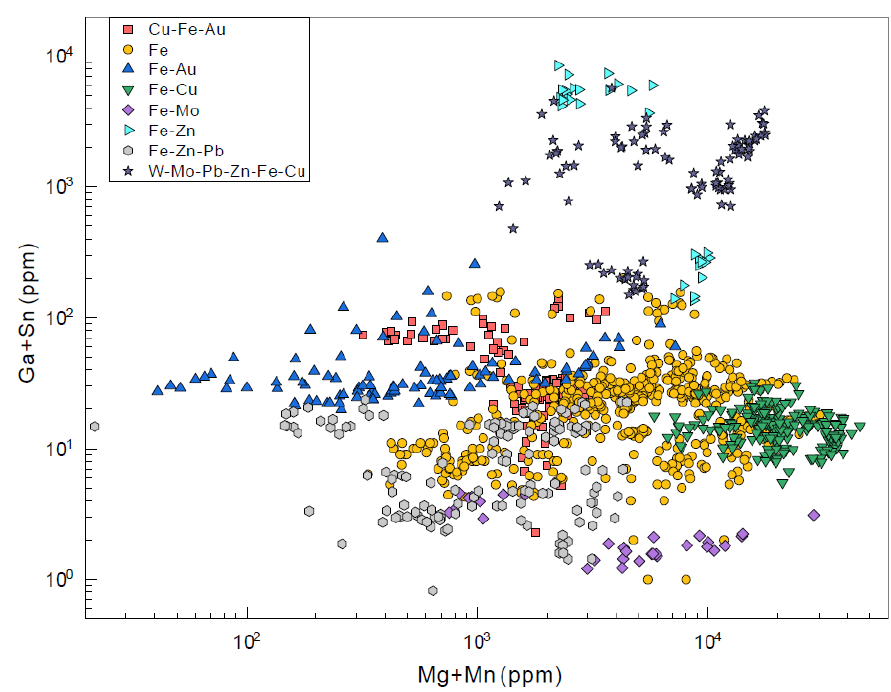
Figure 10. Plot of Mg+Mn vs. Ga+Sn to discriminate magnetite from different mineralization types of skarn deposits. The data points represent individual LA-ICP-MS analyses.